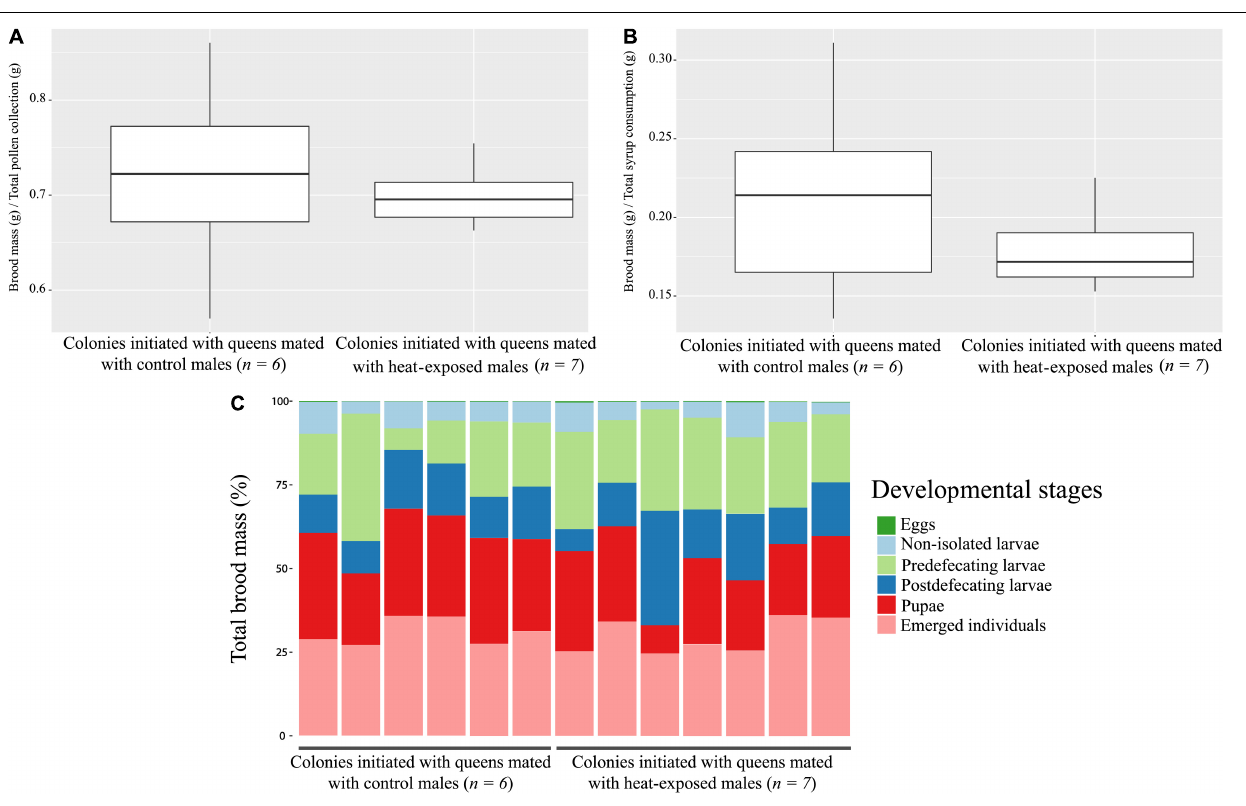
FIGURE 3 | (A,B) Resource collection. Brood mass/pollen collection (A) , brood mass/syrup collection (B) for colonies initiated with queens mated with heat-exposed males (right) and control males (left). No significative difference has been detected between the two groups [Wilcoxon Mann–Whitney, respectively, (A) p = 0.73 and (B) p = 0.37]. (C) Colony dynamics. Brood composition at different developmental stages expressed as percentage of total brood mass for colonies initiated with queens mated with control or heat-exposed males. No significant difference has been detected in brood composition between the two groups (perMANOVA, p =